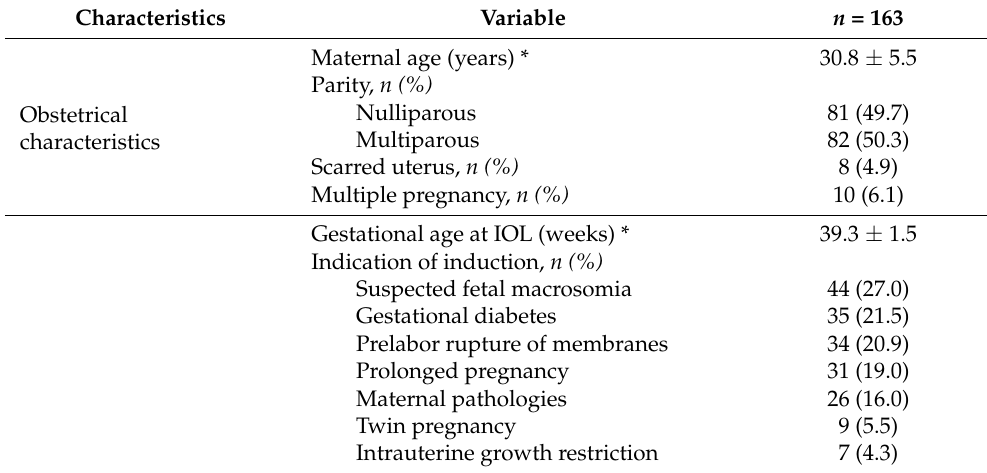
Table 1. Clinical characteristics of the patients undergoing induction of labor (IOL) and neonatal